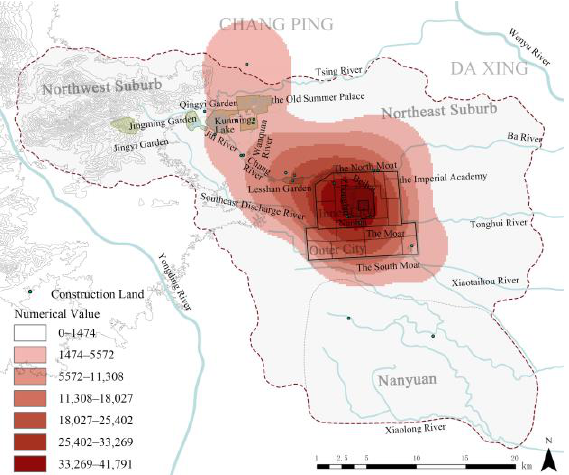
Figure 12. Spatial distribution and density analysis map of garden land.